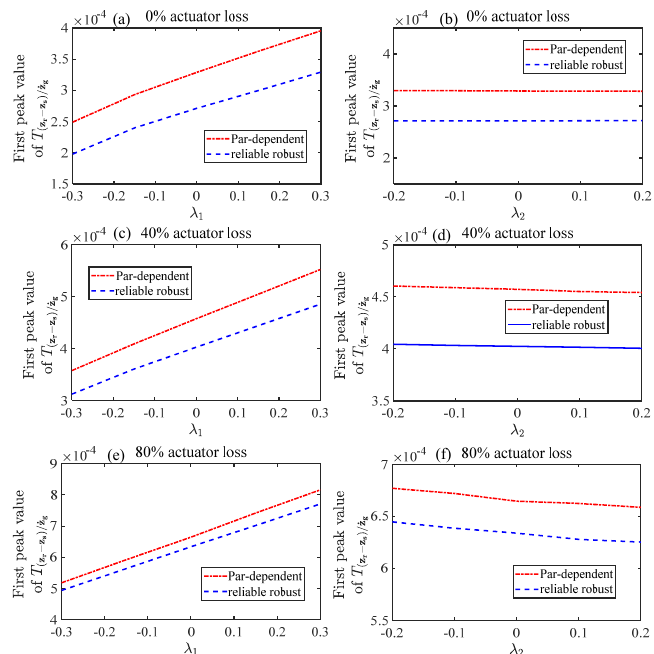
Figure 13. The first peak value of (cid:1846) ((cid:1826) with the parameter-dependent controller and the reliable (cid:1818) (cid:2879)(cid:1826) (cid:1807) )/(cid:1826)(cid:4662) (cid:1807) robust controller versus the uncertain parameters λ 1 and λ 2 : (a) versus λ 1 under 0% actuator loss; (b) versus λ 2 under 0% actuator loss; (c) versus λ 1 under 40% actuator loss; (d) versus λ 2 under 40% actuator loss; (e) versus λ 1 under 80% actuator loss; (f) versus λ 2 under 80% actuator loss.